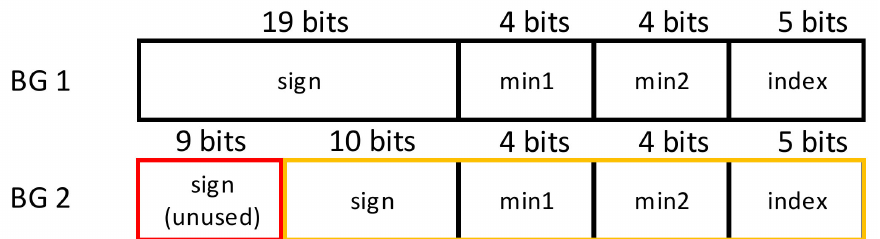
Figure 6. Overall architecture of the proposed dual-mode LDPC Decoder.